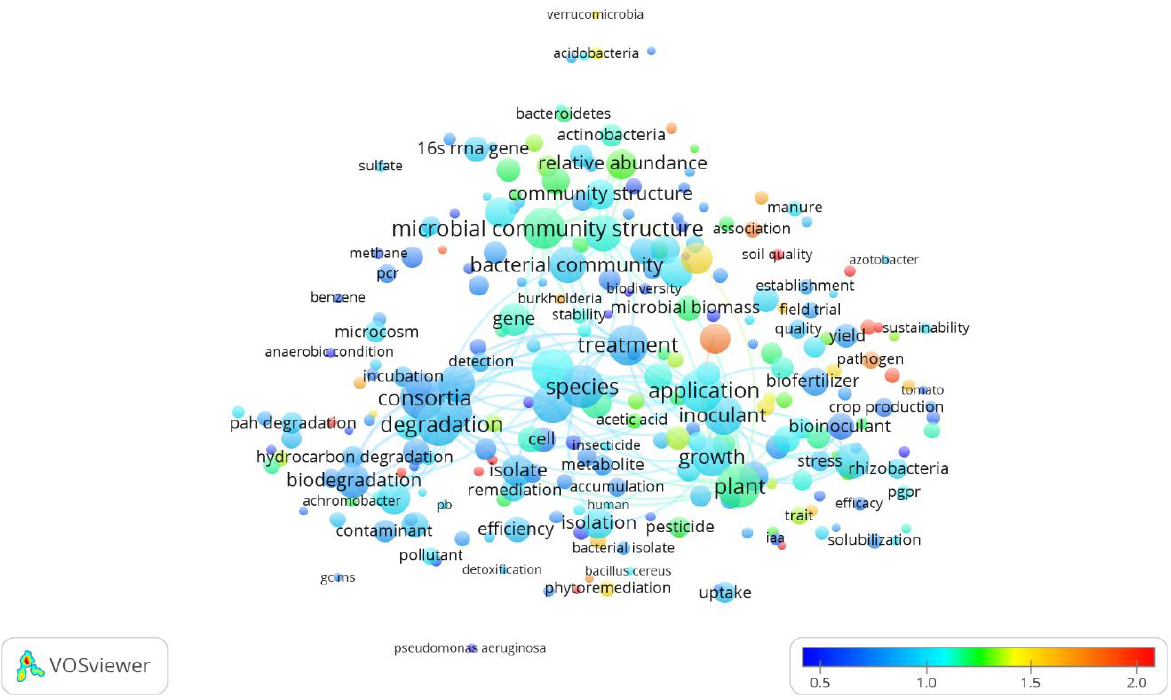
Figure 8. Term map based indexed per citation rate based on all the Scopus plant phenotyping publications/citations. The normalized citation rate scale is represented by the different colors. The size of the term is based on the number of occurrences. The connecting lines indicate the 100 strongest co-occurrence links between terms.